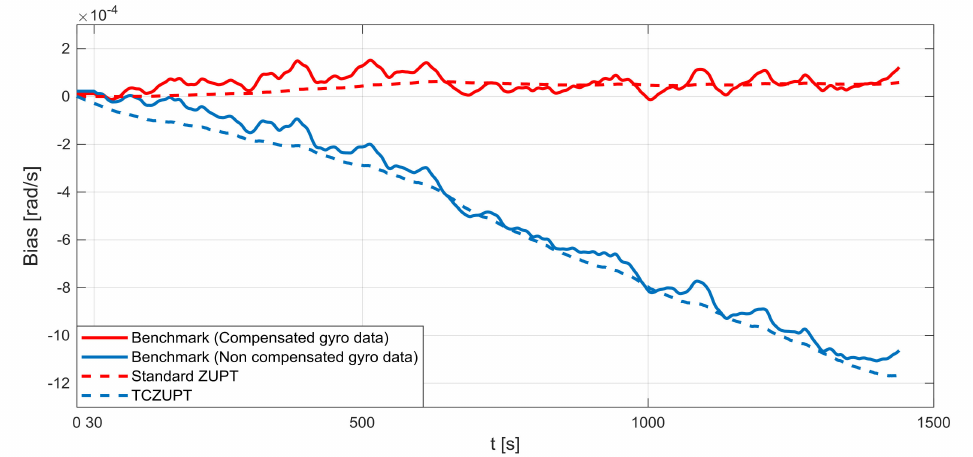
Figure 11. Gyro output bias (nominal condition, x -axis).